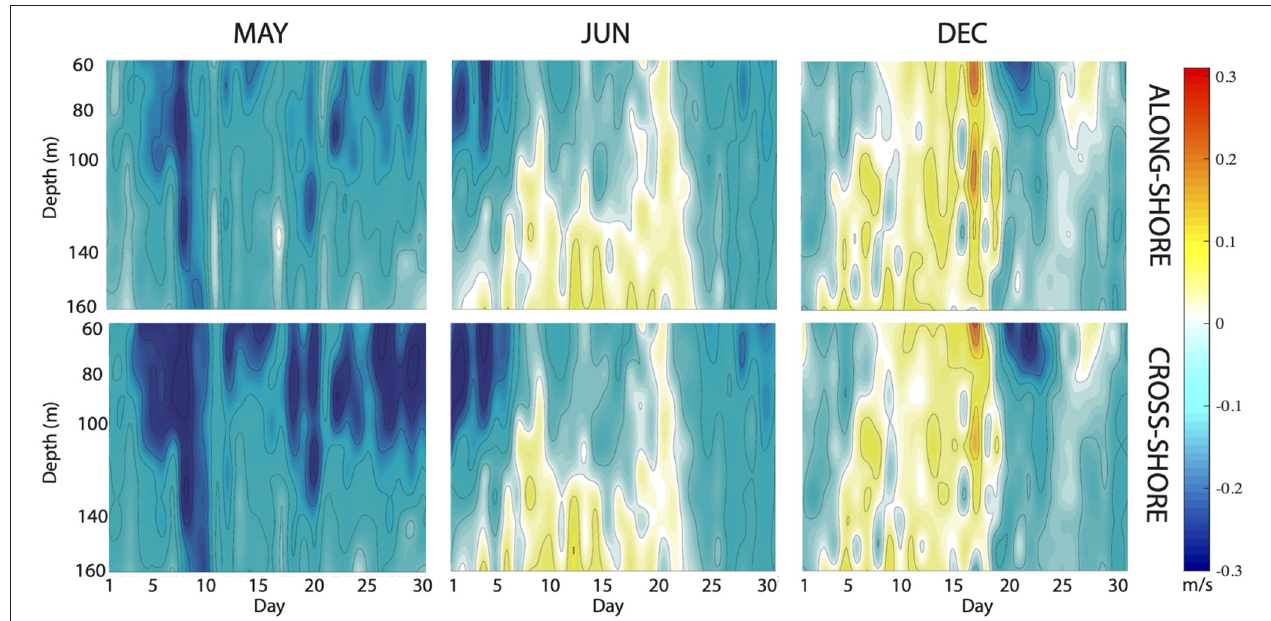
FIGURE 5 | Along-shore (top) and cross-shore (bottom) currents off Santa Marta (ADCP1, Figure 1 ) between 60 and 160 m of depth for May (left), June (center), and December (right) 2007. Positive (negative) velocities are southwestward (northeastward) and northwestward (southeastward) for along-shore and cross-shore components, respectively.